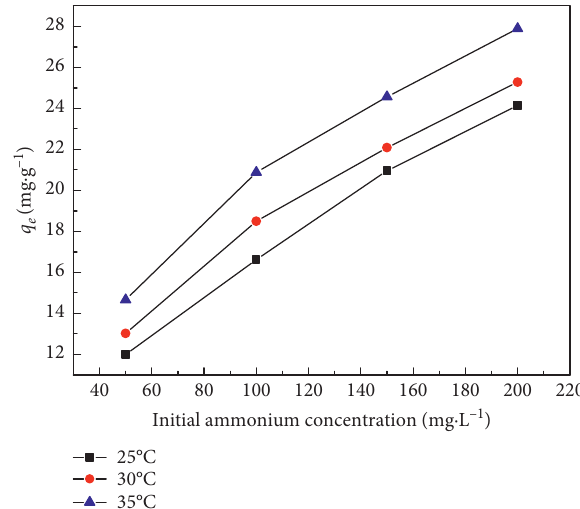
Figure 6: Effect of initial ammonium concentration on ammonium adsorption (EMRZ dosage � 0.2g/100 mL; contact time � 100min; pH value �